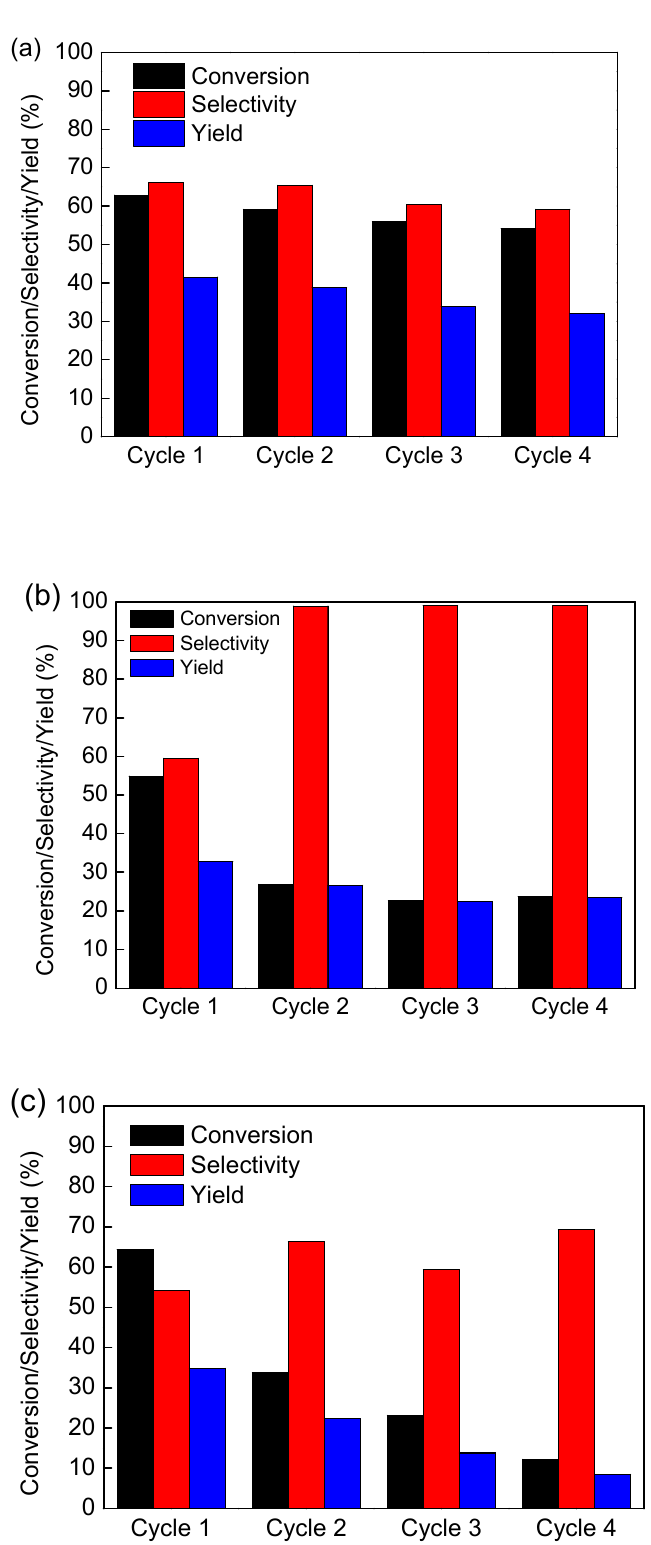
Figure 8. Recycling results of CuNi / MIL-101 ( a ), CuNi / TiO 2 ( b ), and CuNi / C ( c ) catalysts in the oxidation reaction of benzyl alcohol (reaction condition: 0.2 mmol of benzyl alcohol, 1.5 mL of THF, 0.04 g of catalyst, 100 °C, 5 bar, 4 h).